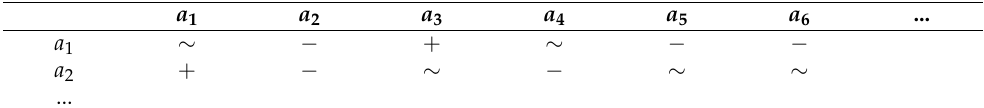
Figure 7. Impact of sequence of actions on the service level. The correlation between actions could be tabulated in a correlation matrix. Rows represent the first applied action in the sequence, and columns represent the second applied action. The cells show the relation between the impact of a sequence of actions and their expected impact on the network as “+”, “ ∼ ”, and “ − ” for positive, weak, and negative relations, respectively. The relations extracted from Figure 7 are tabulated in Table 2. The rest of the correlation matrix shows relations between other actions in the search space. Table 2. Correlation matrix